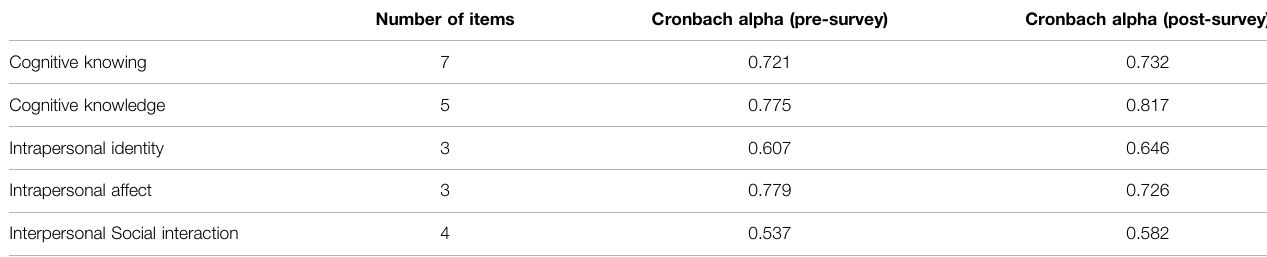
TABLE 2 | Internal reliability of GPI.